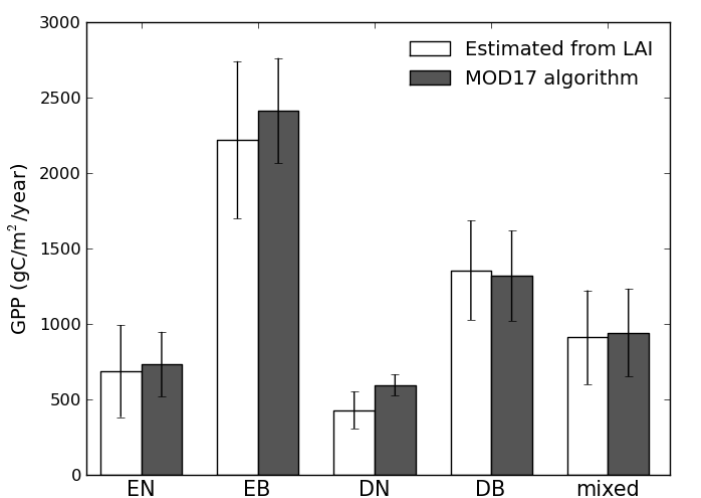
Figure 6. Average and standard deviation of estimated LAI-based and MOD17 annual GPP for each forest type: Evergreen Needleleaf Forest (EN), Evergreen Broadleaf Forest (EB), Deciduous Needleleaf Forest (DN), Deciduous Broadleaf Forest (DB), and mixed forest. The statistics are calculated from all the available 0.5-degree pixels grouped by forest type using the MODIS Land Cover MCD12C1 V005 IGBP classification scheme data.